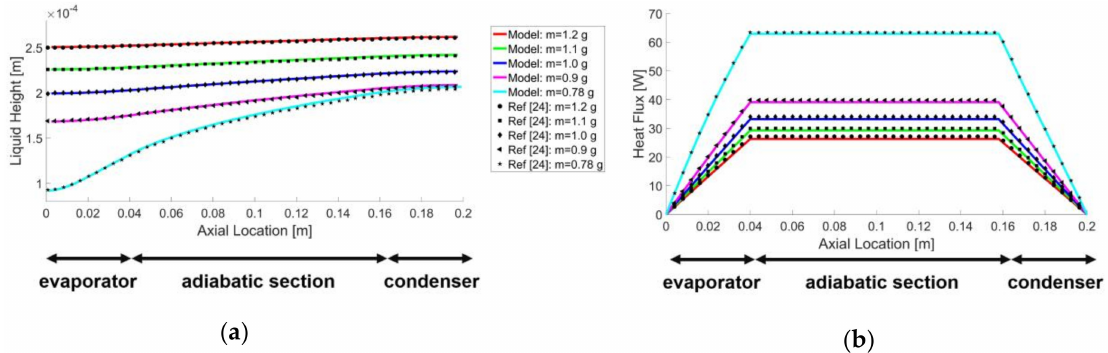
Figure 3. Steady-state modelling results and comparison with Bertossi et al. [24]: ( a ) Liquid height distribution; ( b ) Heat flow along the heat